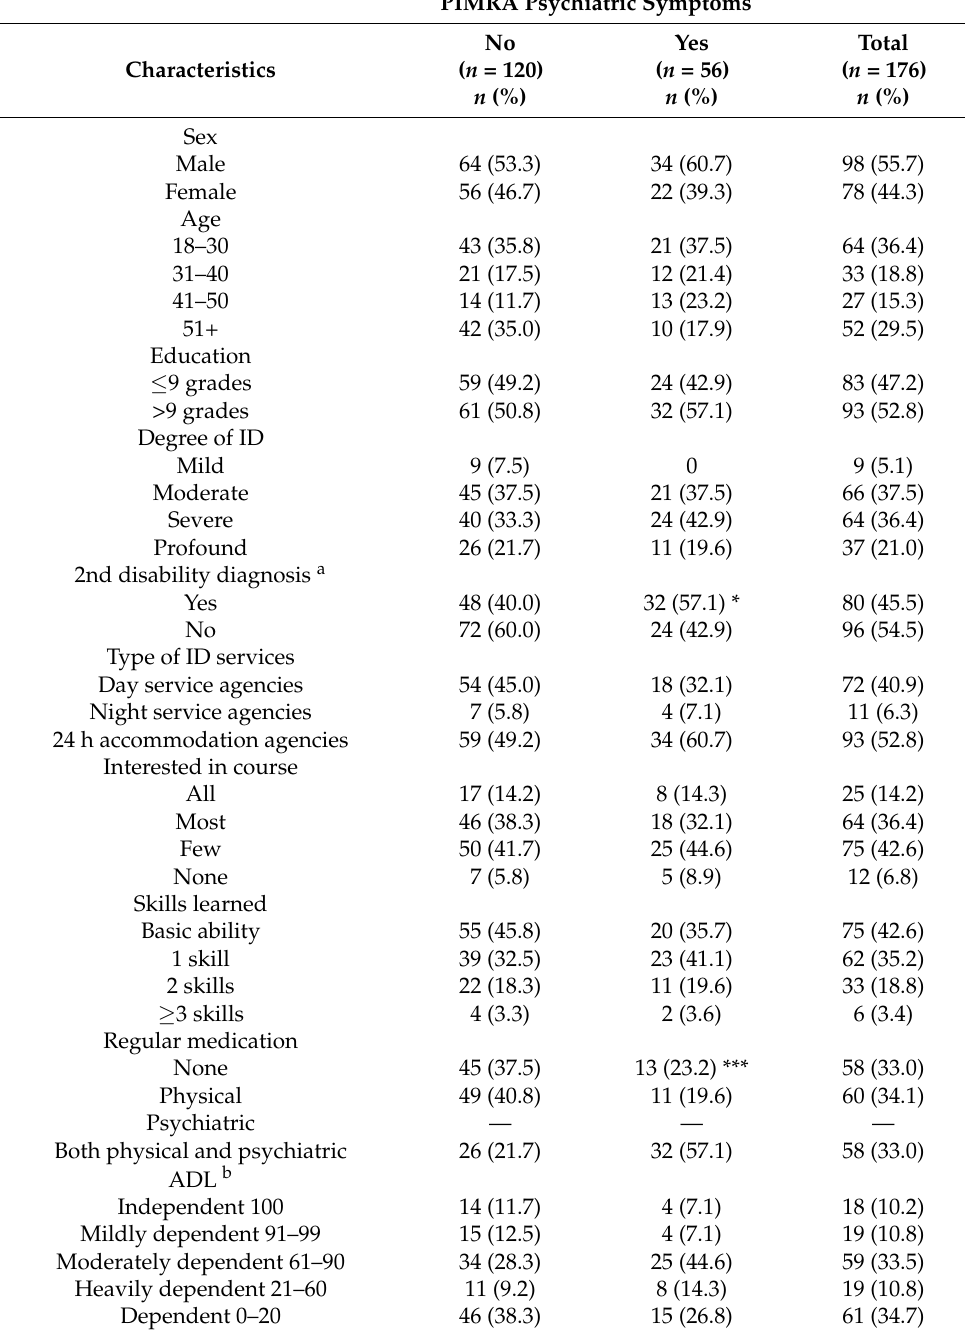
Table 1. Characteristics of adults with intellectual disabilities ( n =